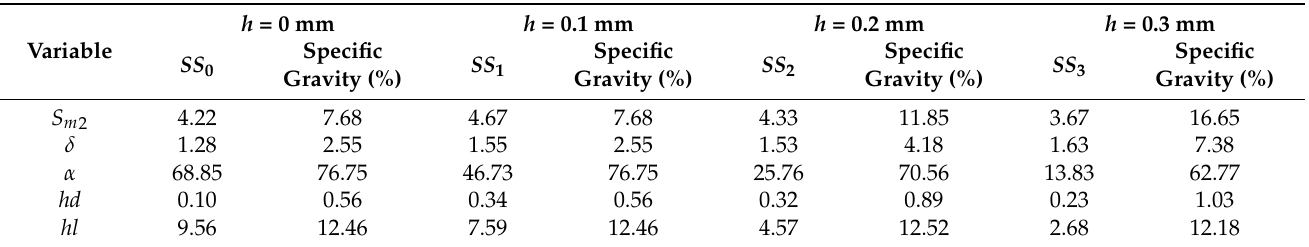
Table 6. Proportion of influence of optimization variables on static electromagnetic force at four working air gaps.